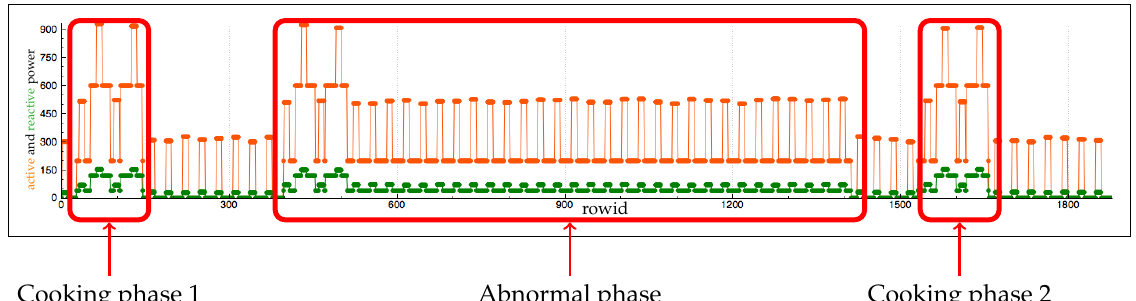
Figure 22. Sample of electricity